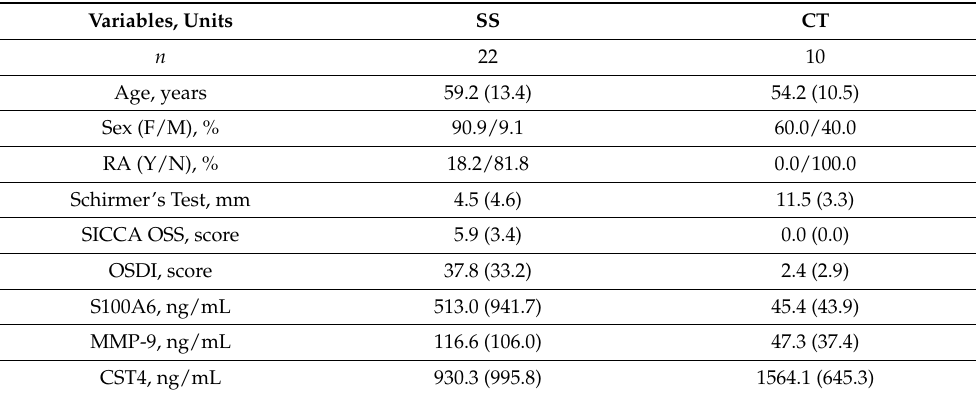
Table 1. The demographics, clinical data and biomarker quantification for each group and the nature of each donor is indicated: Sjögren’s Syndrome (SS) or control